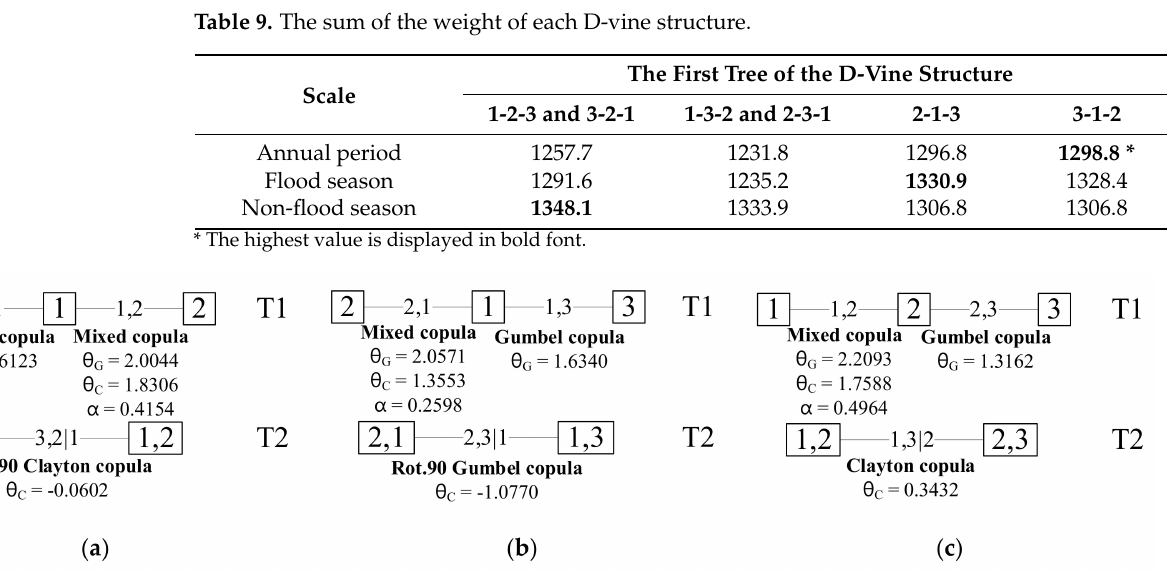
Figure 6. The selected vine structures at three scales: ( a ) is under the annual scale; ( b ) is in flood season; and ( c ) is in non-flood